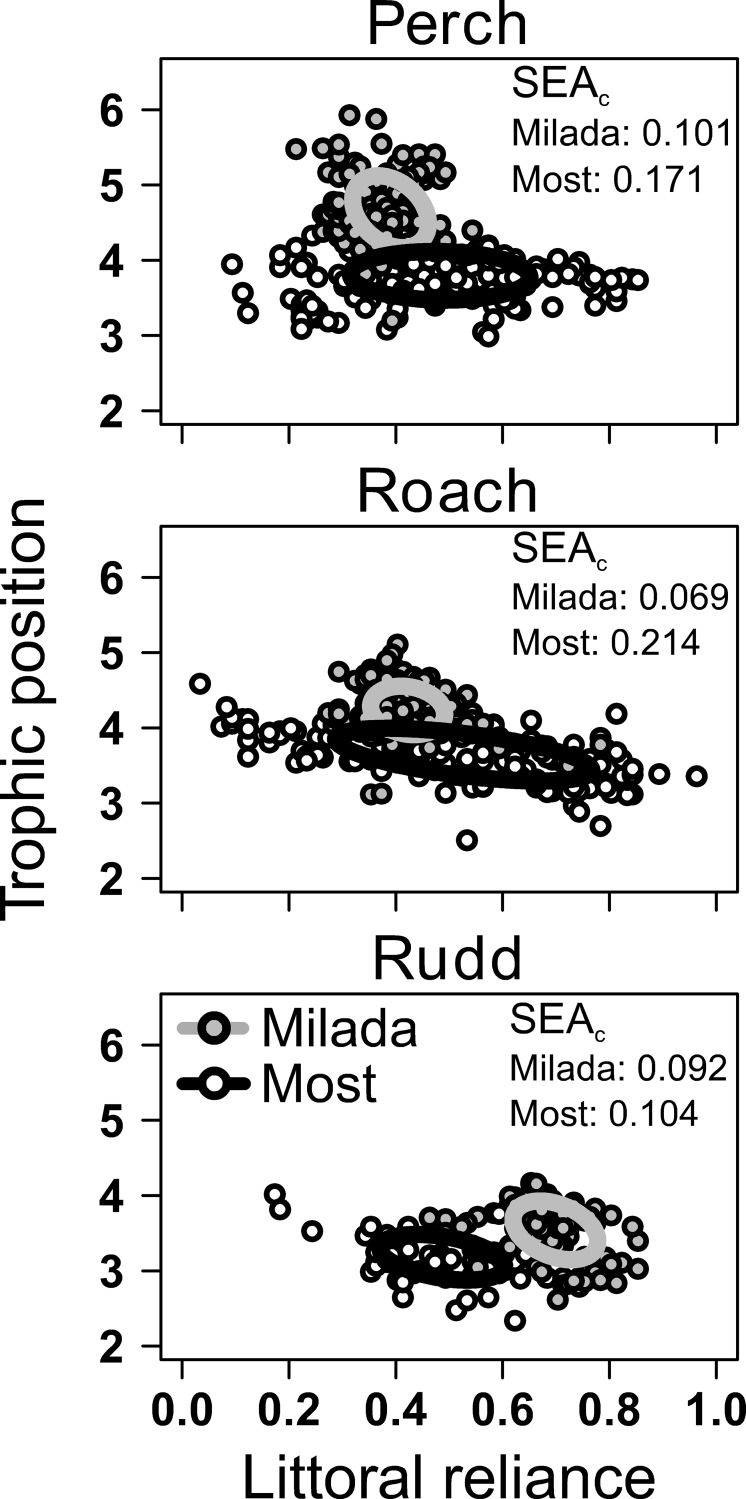
Trophic position versus relative littoral reliance of generalist perch, roach and rudd in the macrophyte-rich Milada (grey dots) and macrophyte-poor Most (white dots).The trophic position (i.e., the average position relative to primary producers at which an organism feeds) and the littoral reliance (i.e., the proportion of assimilated food obtained from the littoral habitat) are based on the isotopic values of fish muscle tissue and of the littoral and pelagic basal resources (see Materials and methods and [38] for details). The ellipses depict the core isotopic niches of the fish populations estimated as the sample-size corrected standard ellipse areas (SEAc; estimates shown in the figures; see [68] for details).